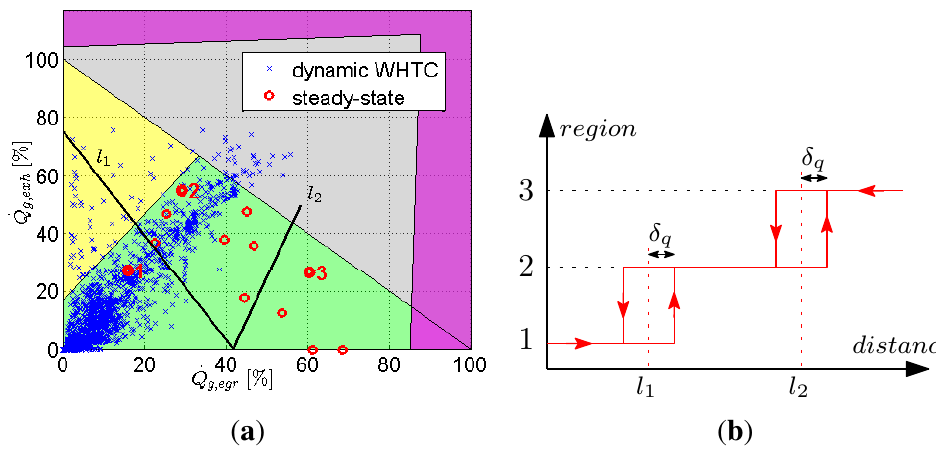
Figure 6. ( a ) Cold-start World Harmonized Transient Cycle and steady-state points within the waste heat recovery (WHR) system operating area (green) and limitations: cooling capacity (grey), high emissions (yellow), ethanol decomposition (magenta); ( b ) Schematic representation of the switching mechanism with